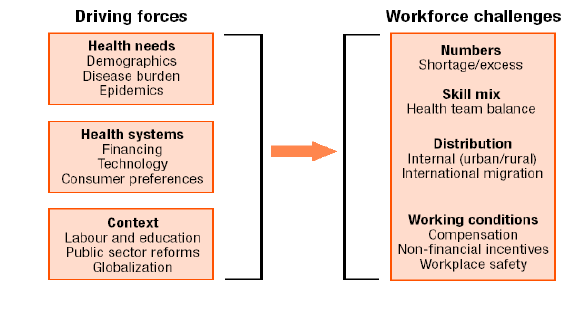
Figure 5: Forces driving the workforce Health